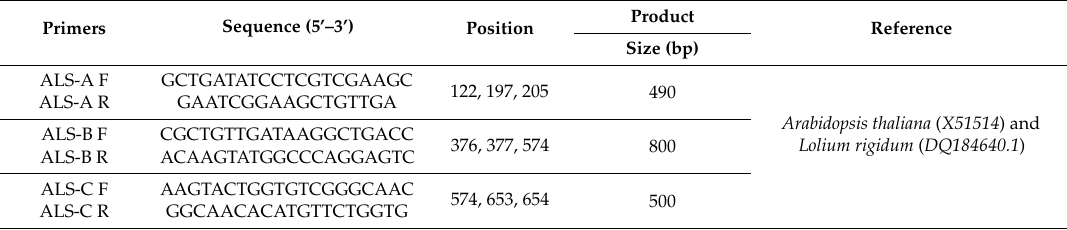
Table 2. Primers used for PCR and sequencing